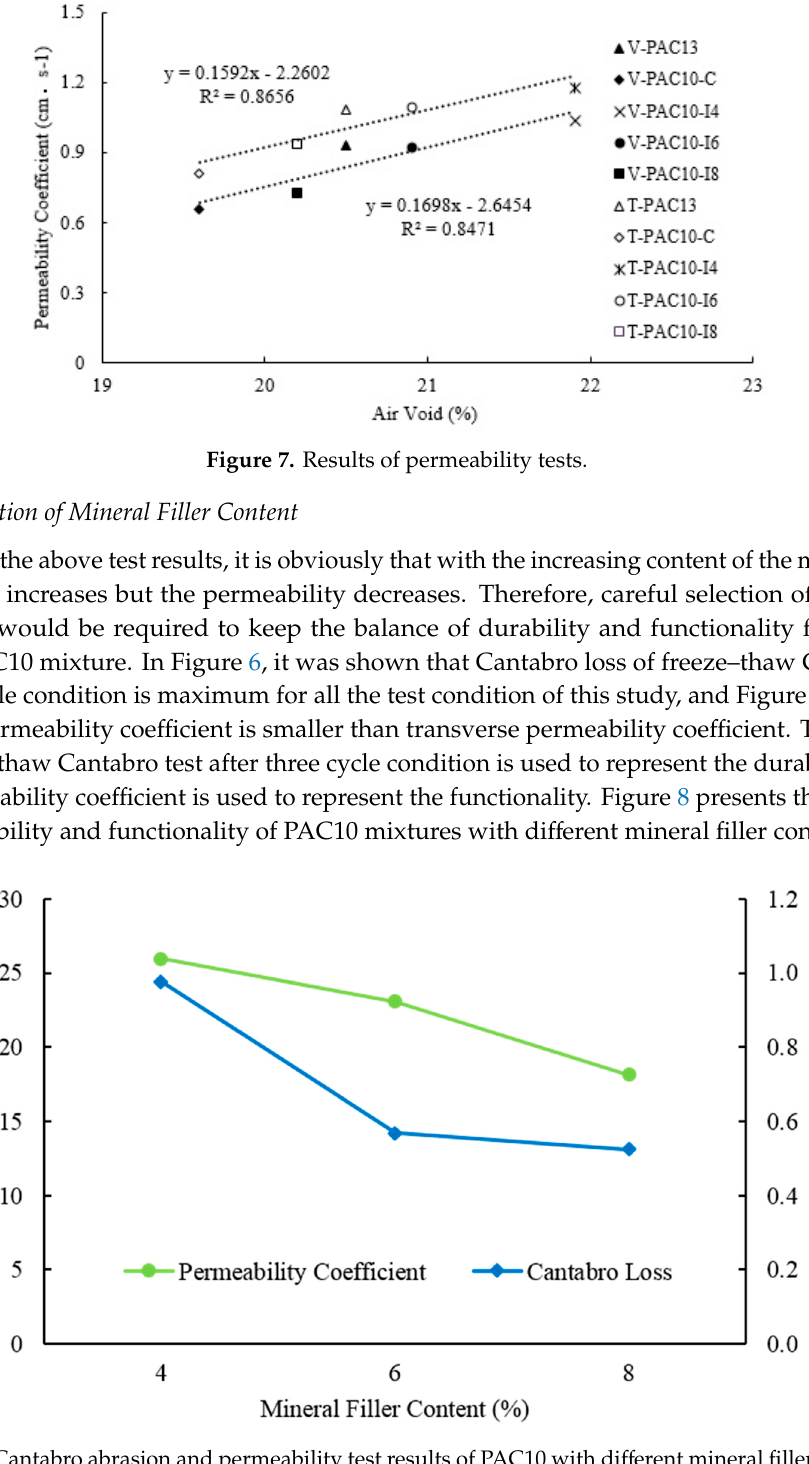
Figure 8. Cantabro abrasion and permeability test results of PAC10 with different mineral filler